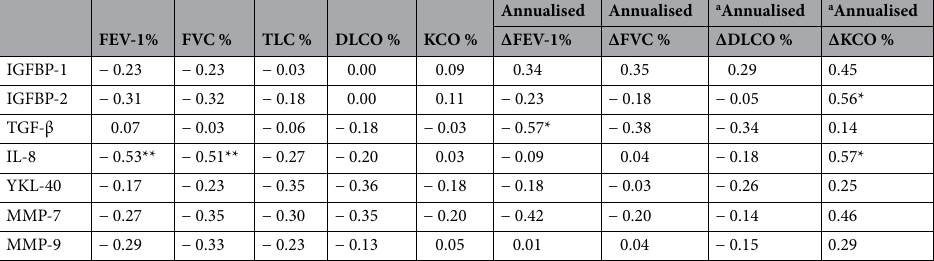
Table 3. Correlation between sputum biomarkers and lung function in SSc group. Spearman correlation: p < 0.05*, p < 0.01**. a Annualised (cid:31) DLCO % and (cid:31) KCOn = 14 .